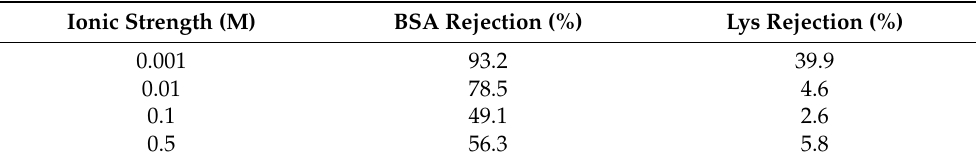
Table 2. Membrane protein rejection at the end of filtration for BSA and Lys of PVP-ZrO 2 membrane at the tested range of ionic strength (a) . Ionic Strength (M) BSA Rejection (%) Lys Rejection (%)